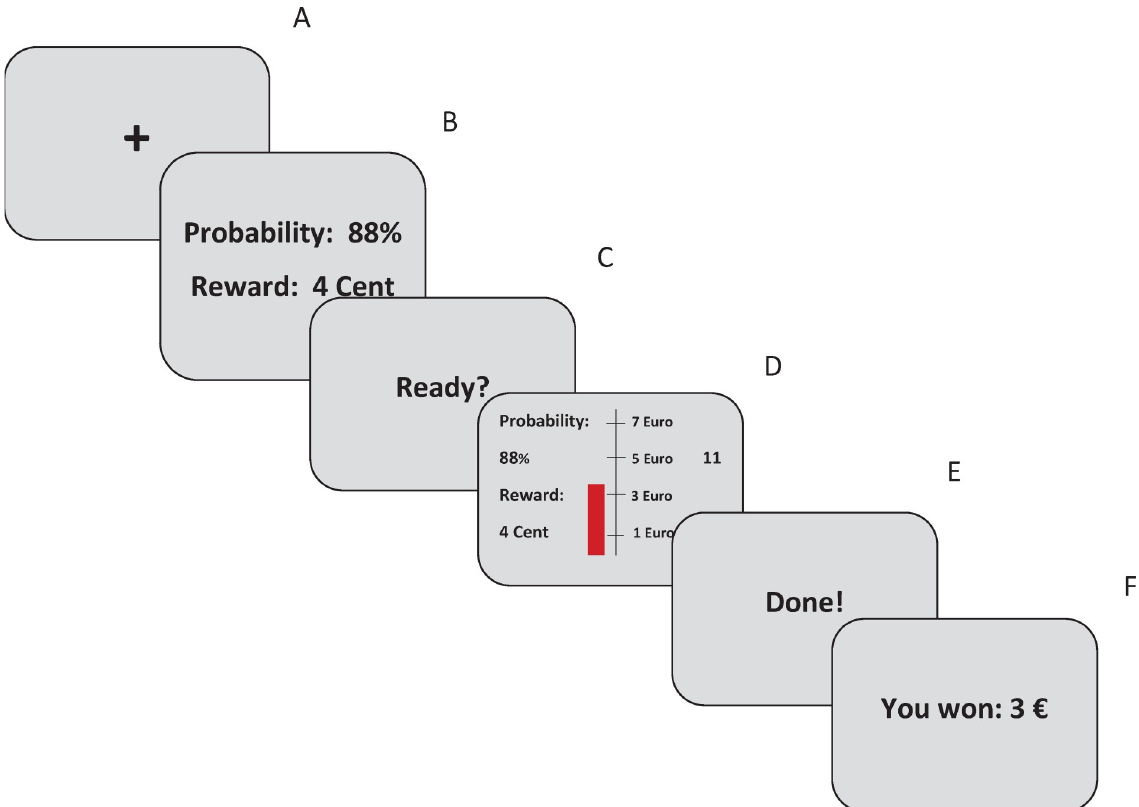
Fig 2. Schematic illustration of one trial of the modified EEfRT. A fixation cross (1s, A) is followed by a screen showing probability of reward attainment and reward magnitude per click for 3s (B). Then, after presentation of a ready–screen (1s, C), the main screen for the trial showing a red bar that grows with each click is presented alongside a scale, indicating the current monetary gain and a countdown (20s, D). Finally, task completion is signaled (1.5s, E) and a feedback screen shows the amount of money won (2s, F).